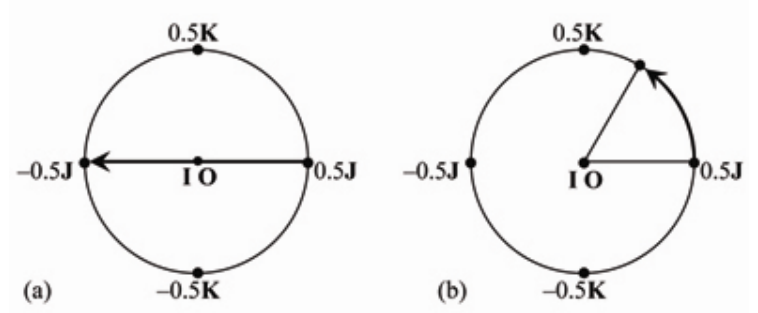
Figure 10 The effect in the antistigmatic plane of the physical operations in Figure 6 on a 0.5-D Jackson cross-cylinder in primary orientation. (a) shows the effect of flipping the lens; the power is changed from 0.5 J D to – 0.5 J diametrically across the circle. (b) shows the effect of turning the lens 30° anticlockwise; the power is changed from 0.5 J D to 0.25 J + 0.433 K D 60º anticlockwise around the